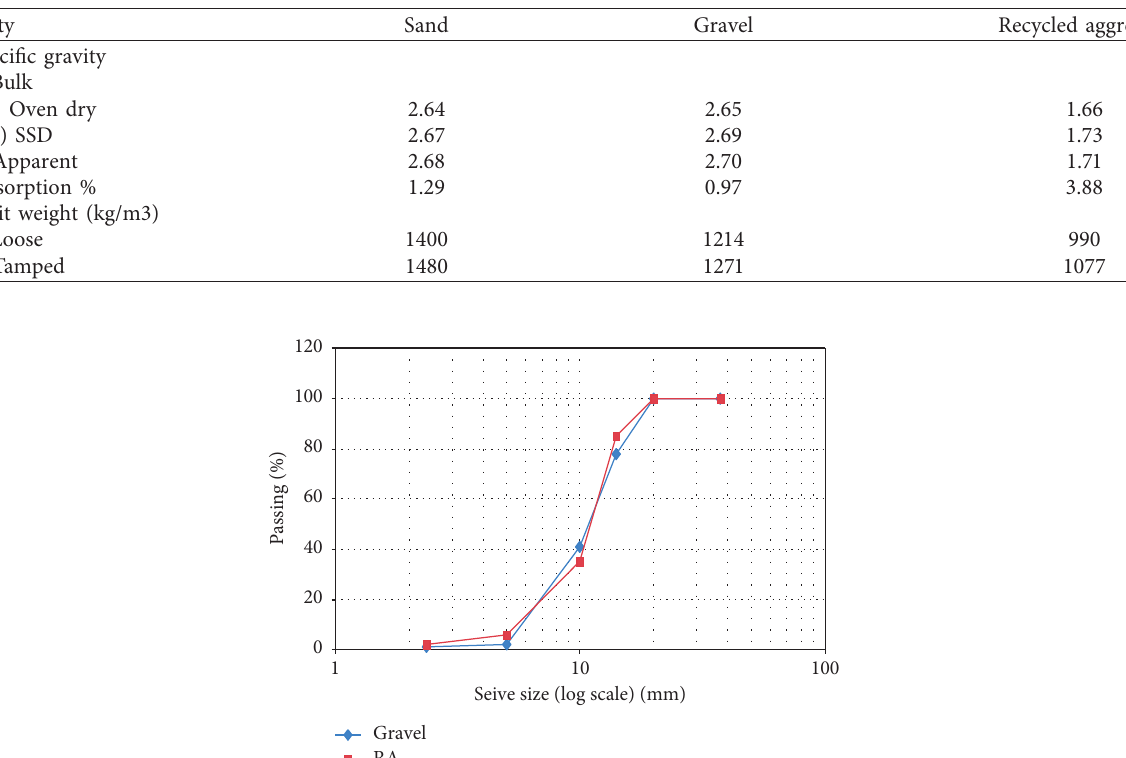
Table 4: Properties of the used aggregate.